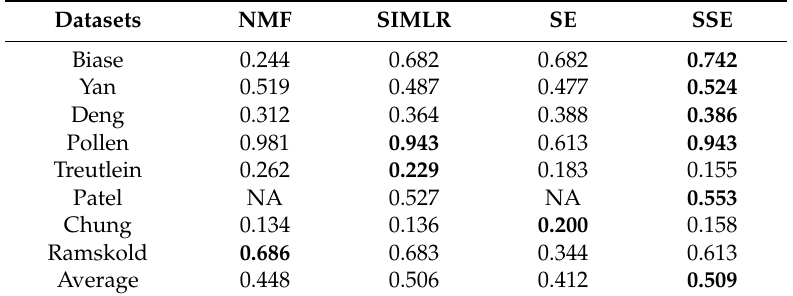
Table 3. Cluster performance comparison of NMF, SIMLR, SE and SSE in terms of ARI (Adjusted Rand